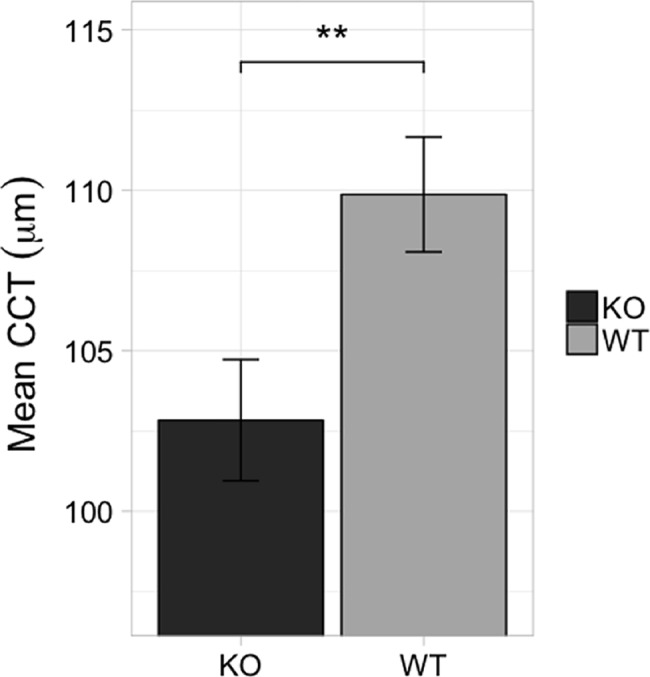
The effect of knocking out Pou6f2 on CCT.The average CCT (bars represent SEM) from Wild-type (WT) mice and Pou6f2-null (KO) mice is shown. In the Wild-type littermates (n = 10) the cornea was on average significantly (p < 0.01) thicker than observed in the Pou6f2-null mice (n = 6).